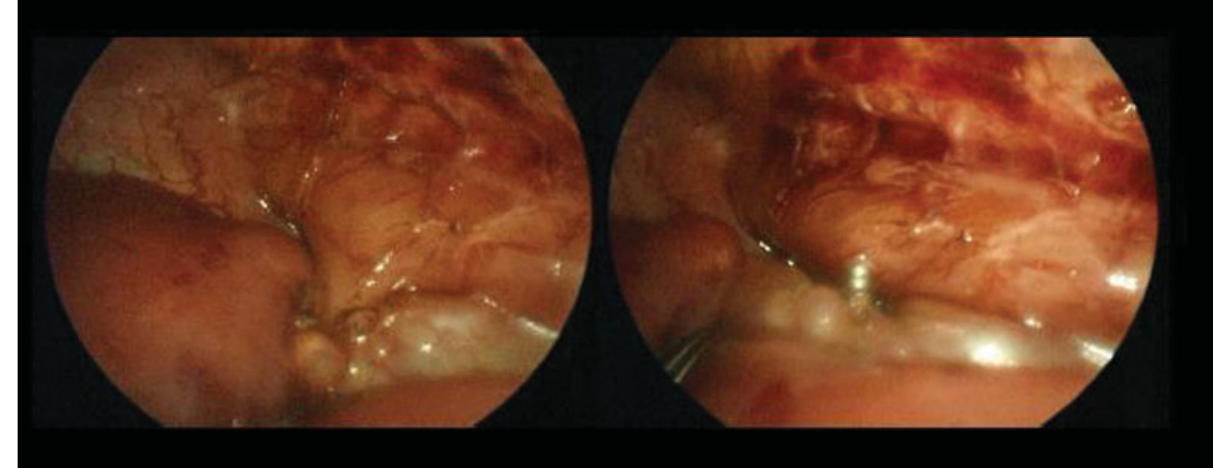
Fig. 2 Intraoperative images of the anomalous bronchus arising from the esophagus before and after ligation with titanium